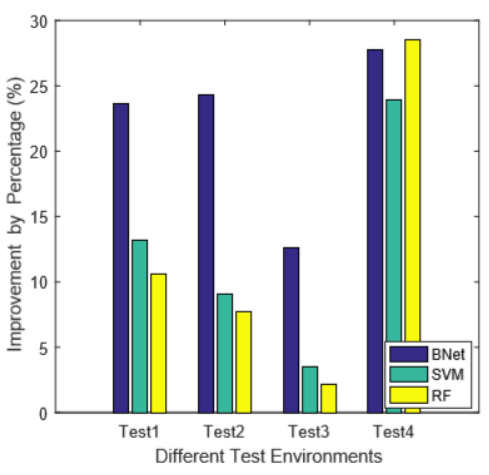
Figure 14. The overall improvements compared with the state-of-the-art